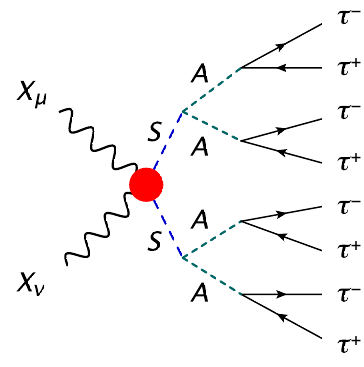
Figure 1 . The main DM annihilation process of two-step cascades, X (cid:22) X (cid:23) ! SS ! 4 A ’s ! 8 (cid:28) ’s, relevant to the GC gamma-ray excess. The red shaded region contains interactions shown in (cid:12)gure 2.